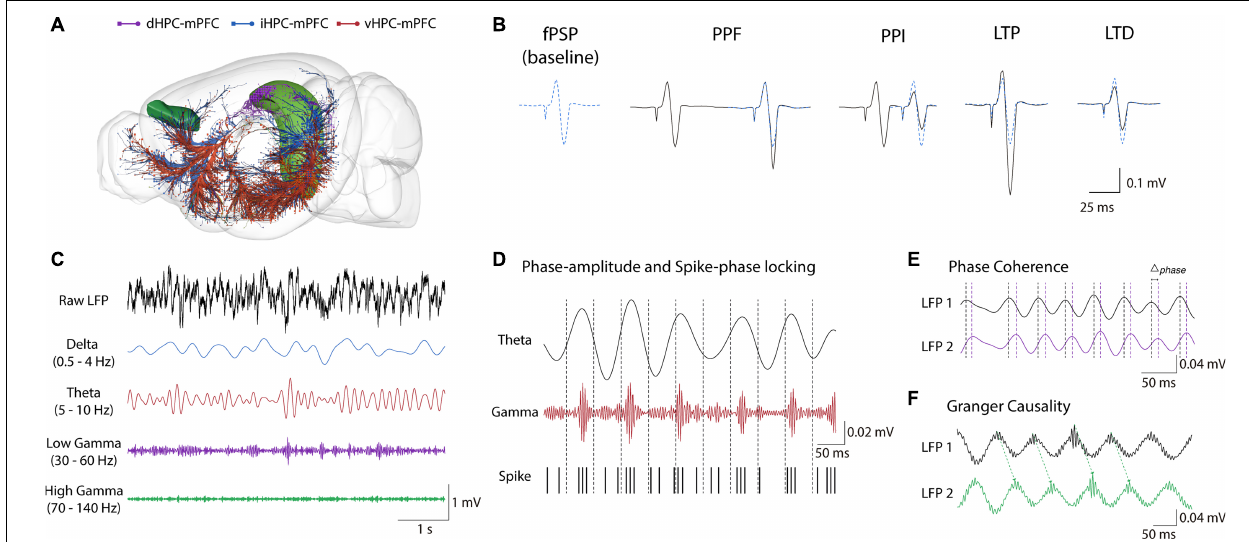
FIGURE 1 | Hippocampus-mPFC anatomical and electrophysiological measures. (A) Distinct HPC projections along the septo-temporal axis. Purple: dHPC; Blue: iHPC; Red: vHPC (brain sites adapted from the Brain Explorer, Allen Institute). (B) Electrophysiological measures of synaptic plasticity in HPC-mPFC pathway. From Left to right: typical fPSP baseline of the iHPC-mPFC pathway, short-term plasticity (PPF and PPI), and long-term plasticity (LTP and LTD) representatives. Paired-pulse stimulations facilitate or inhibit fPSPs response in longer and shorter interval stimulus, respectively. High-frequency stimulation induces LTP while low frequency typically induces LTD. (C) Representative traces of LFPs. Top to down: Raw LFP followed by band-filtered signal in the oscillatory activity commonly investigated in HPC-mPFC (Delta: 0.5–4 Hz, Theta: 5–10 Hz, Low-Gamma: 30-60 Hz, High-Gamma: 70-140 Hz). (D) Phase-amplitude and Spike-phase locking. In the example: Theta coupling to Gamma amplitude and neuronal spikes. These methods measure how the amplitude of a fast activity or the firing rate in one region is modulated by phase of the oscillatory activity in another region (E) Synchrony measures. In the example: Phase difference ( (cid:49) phase ) between theta oscillatory activity across time. Synchrony methods such as spectral and phase coherence measure the consistency of (cid:49) phase between two signals over time. (F) Granger Causality. Granger Causality is inferred when the future values of a signal are predicted using prior values of another signal. fPSP, field post-synaptic potential; PPF, paired-pulse facilitation; PPI, paired-pulse inhibition; LTP, long-term potentiation; LTD, long-term depression; LFP, local field